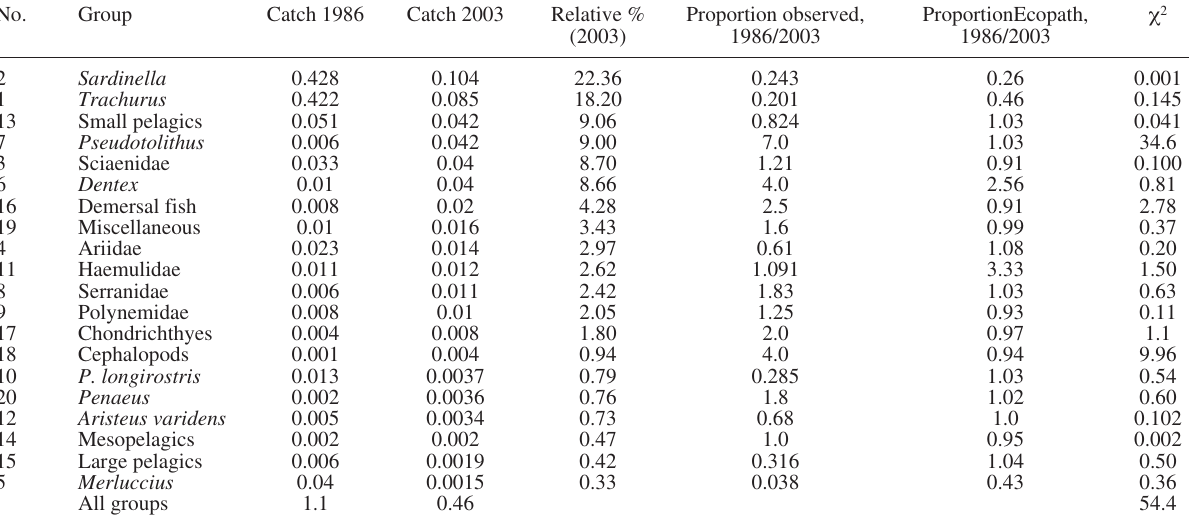
Table 3 . – Catch observed in 1986 and 2003 for groups in the Angola ecosystem (t km –2 ), and relative and accumulated proportions of landings in 2003. Relative observed fishing in 1986/2003 and calculated fishery 1986/2003 by Ecopath with Ecosim were compared with the Chi-squared test. The result was χ 2 =53.6 ( p =0.00), but if the Pseudotolithus compartment was removed, χ 2 =18.3, p =0.44 (see text).